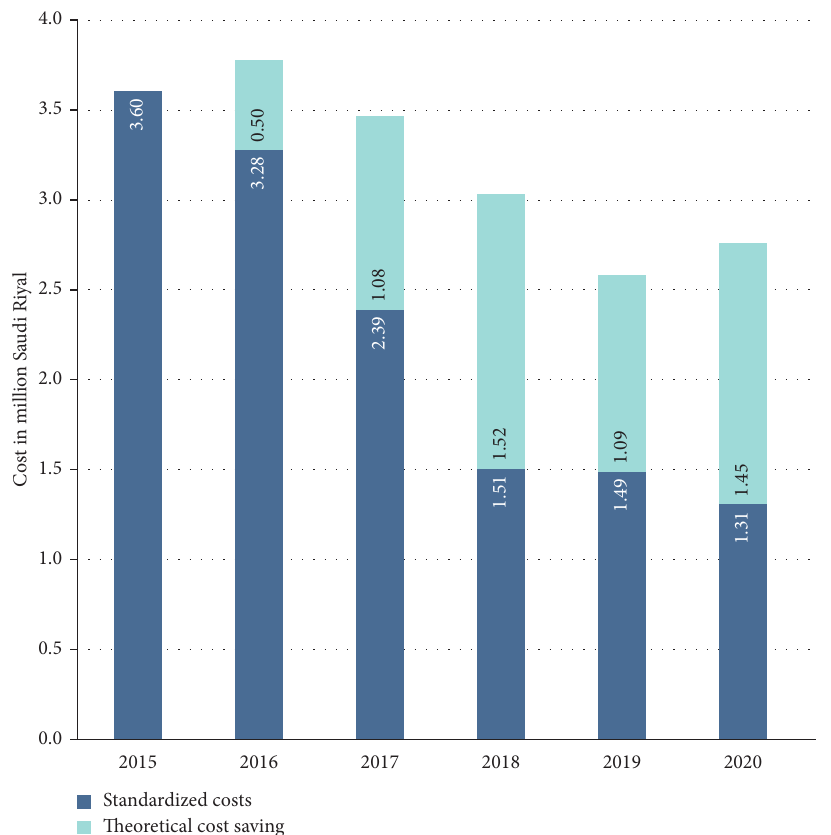
Figure 3: Estimated theoretical cost savings on restricted injectable antimicrobials following the implementation of the antimicrobial stewardship program. Theoretical cost savings for a given year are estimated as the difference between the standardized costs for the year and the standardized costs for baseline (2015) adjusted for the number of patient days of the respective year (2016, 2017, ... ). This estimate is based on the assumption that, in absence of ASP, the antimicrobial consumption per patient day is consistent, which would result in invariable cost per patient day by using the mean prices for each agent. Table 1: Change in antibiotics defined daily doses per 1,000 patient days following the implementation of the antimicrobial stewardship